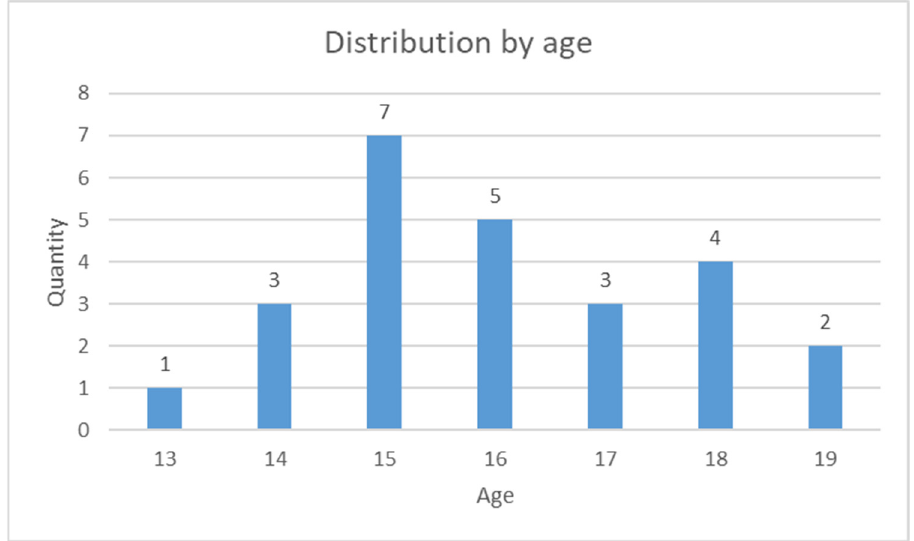
Figure 2. Distribution by age (N = 21